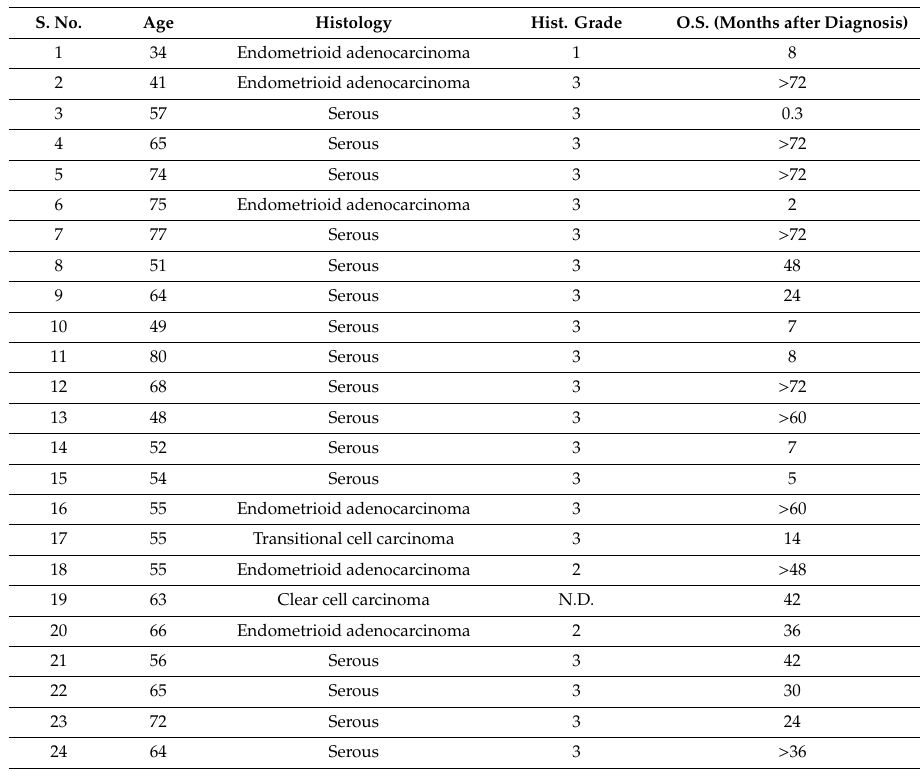
Table 1. Patient characteristics.